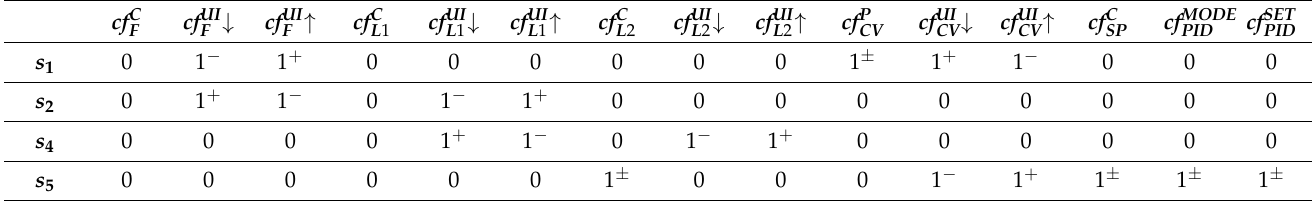
Table 6. Theoretical matrix of sensitivities of diagnostic checks to single cyber-faults.